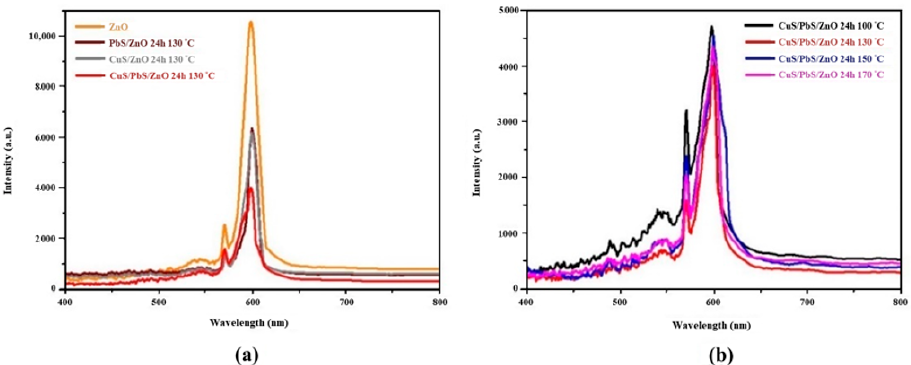
Figure 5. PL spectra of the prepared photocatalysts at 579 nm as the excitation wavelength ( a ) Var- ious sulfides supported on ZnO photocatalyst, and ( b ) CuS/PbS/ZnO photocatalysts prepared at different hydrothermal temperatures.